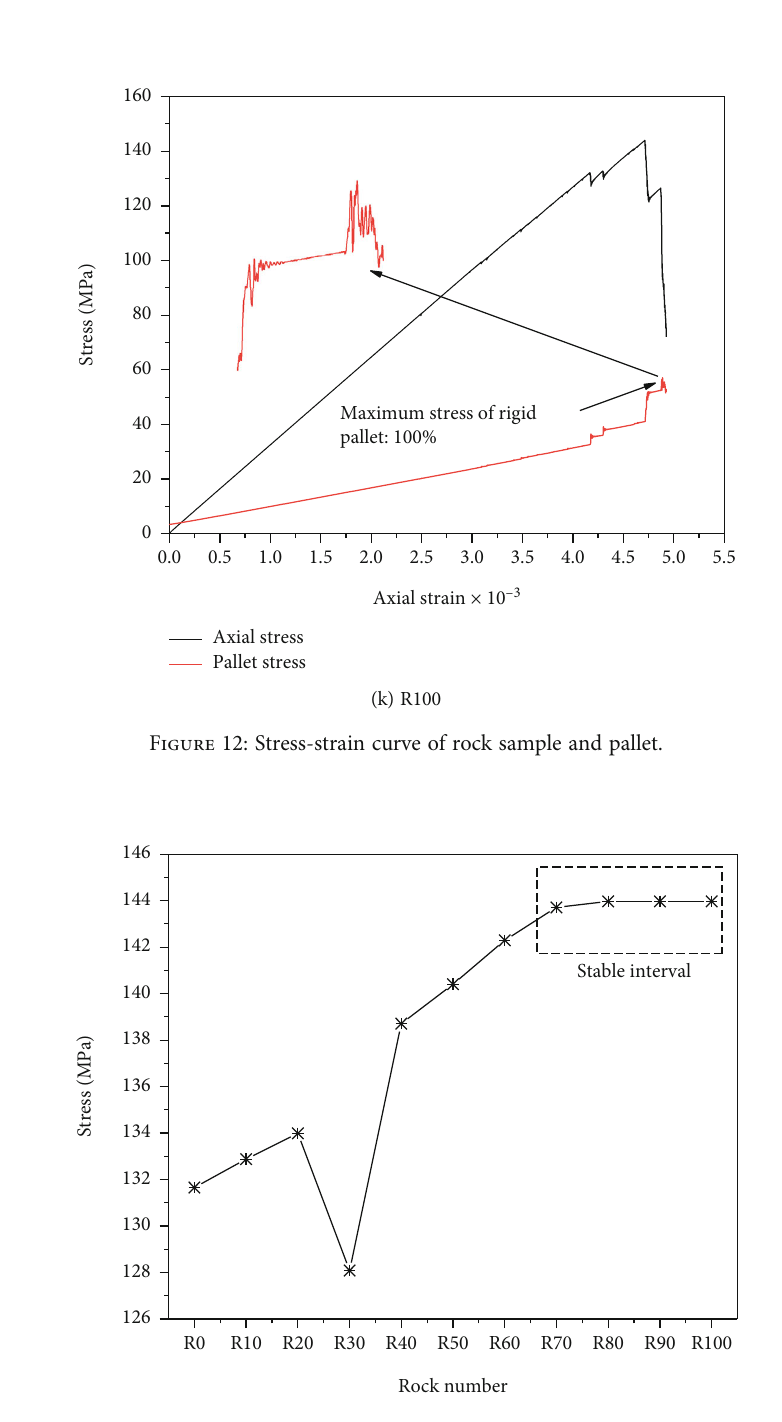
Figure 13: Strength-CRV